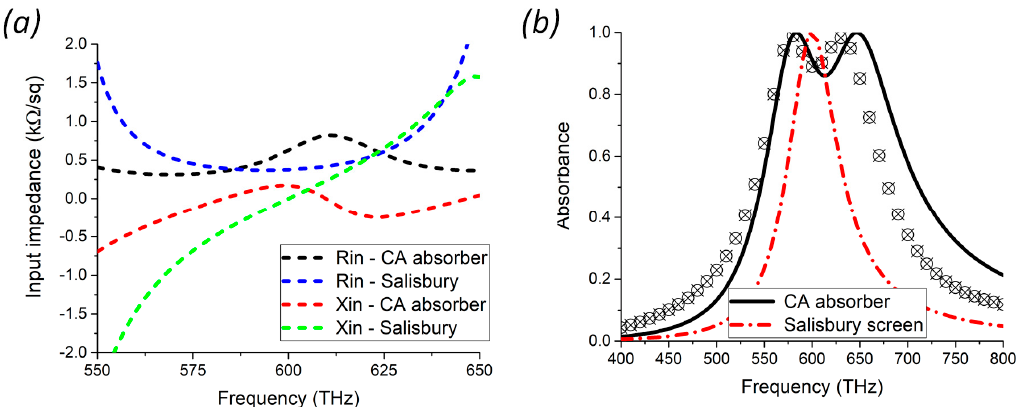
Figure 4. ( a ) The input impedance of the designed CA absorber and of an equivalent Salisbury screen with the same thickness. ( b ) The analytical and numerical absorbance (absolute value) of the designed CA absorber and of an equivalent Salisbury screen with the same thickness. Ticks represent the results of full-wave simulations.